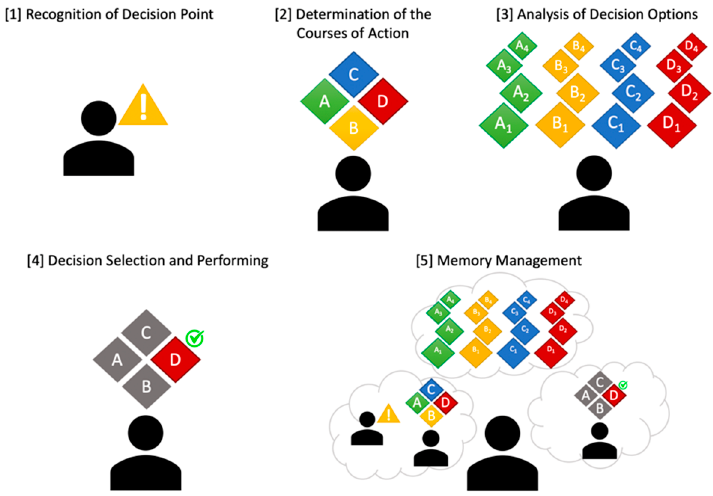
Figure 1. General view of decision-making phases.